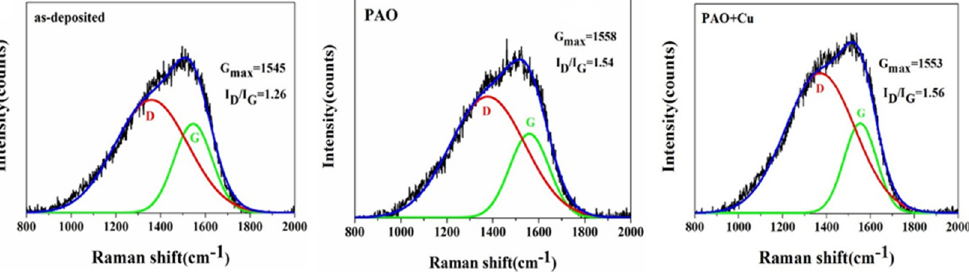
Figure 11. Raman spectra and fitting results of steel/DLC friction pair lubrication with PAO6 and PAO6 + 0.1 wt.% Cu. PAO6 + 0.1 wt.% Cu.